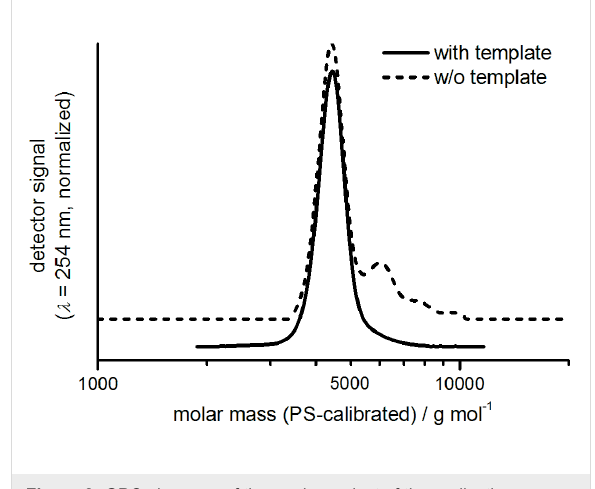
Figure 2: GPC elugrams of the crude product of the cyclization reac- tion of 1a (—) and 1d (- - -), respectively. For a better view the curves are vertically